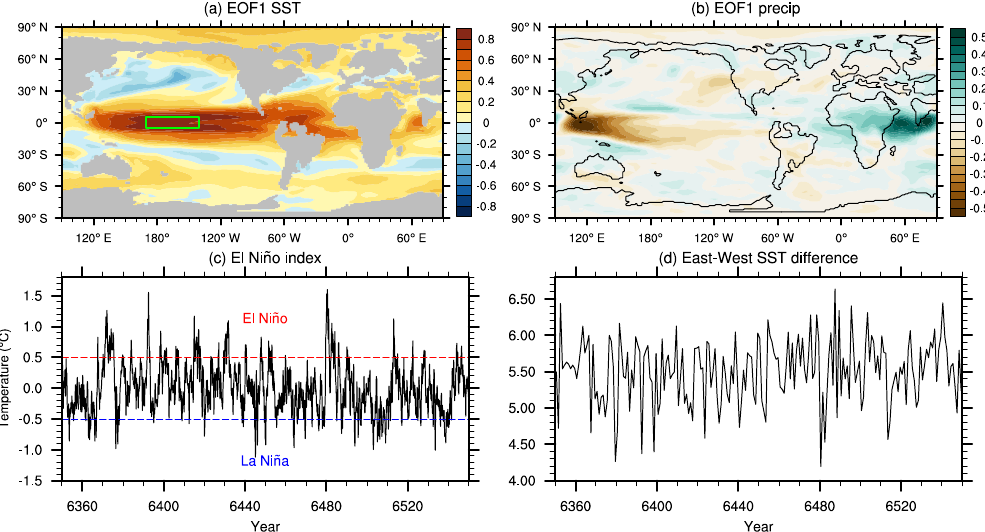
Figure 5. (a) First empirical orthogonal function (EOF1) of the monthly sea surface temperature anomaly (SST), and (b) precipitation. From the EOF1 of SST we then define an El Niño index region from 170 ◦ E to 140 ◦ W, and from 5 ◦ S to 5 ◦ N, as shown in the green box in (a) . This region was chosen as an “El Niño index” to be representative of strongest variability in Pacific SST. (c) El Niño index variability in monthly SST anomaly. (d) Annual mean east–west Pacific SST